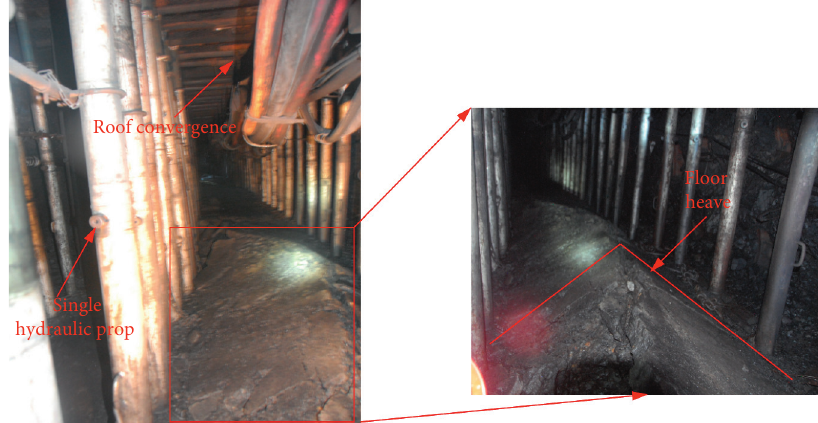
Figure 3: Floor heaving in mining-induced advanced abutment pressure area of 2-2092 roadway.